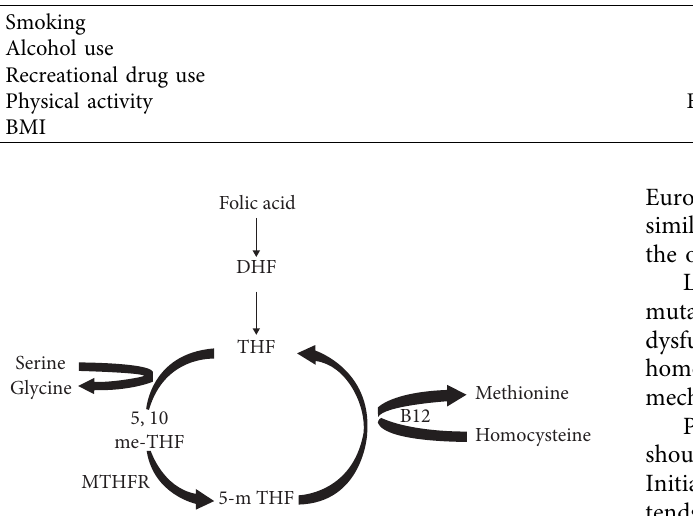
Table 1: Social history.